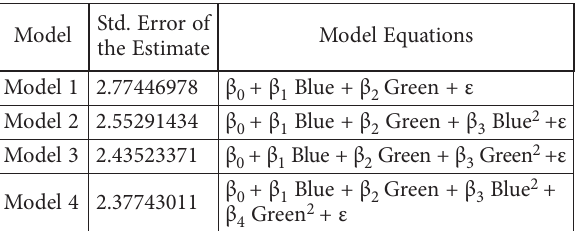
Table 5. The combinations of blue and green channels Std. Error of Model the Estimate